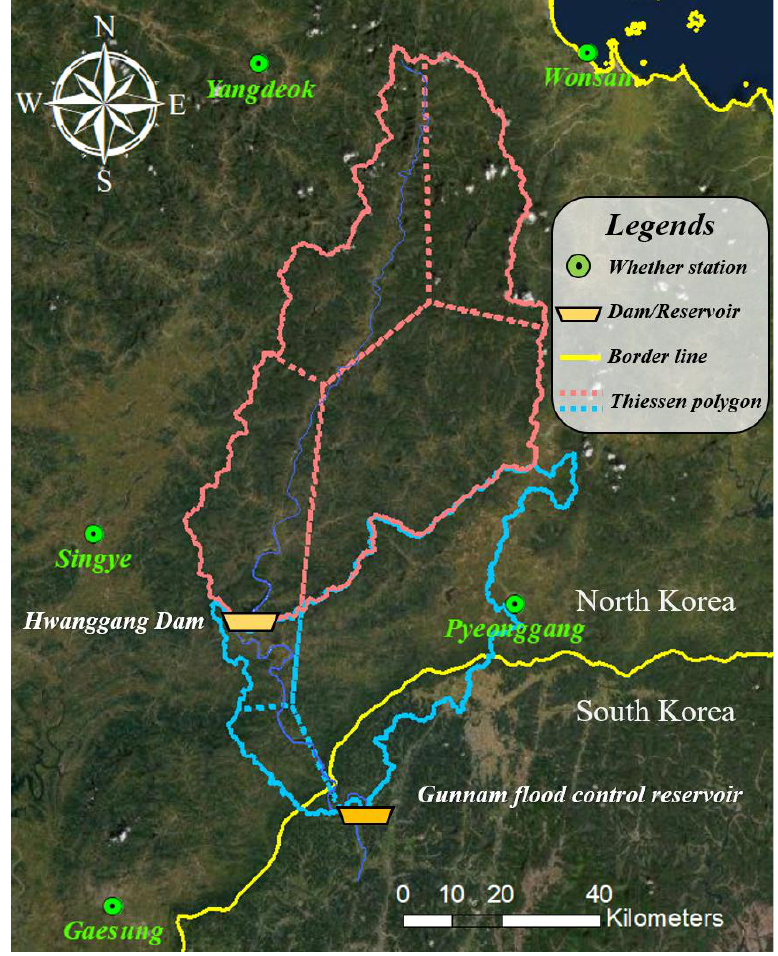
Figure 2. The Thiessen polygon of the Imjin River basin using weather stations in North Korea. Table 1. Th weights of the weather stations for the Thiessen polygon in the study area.